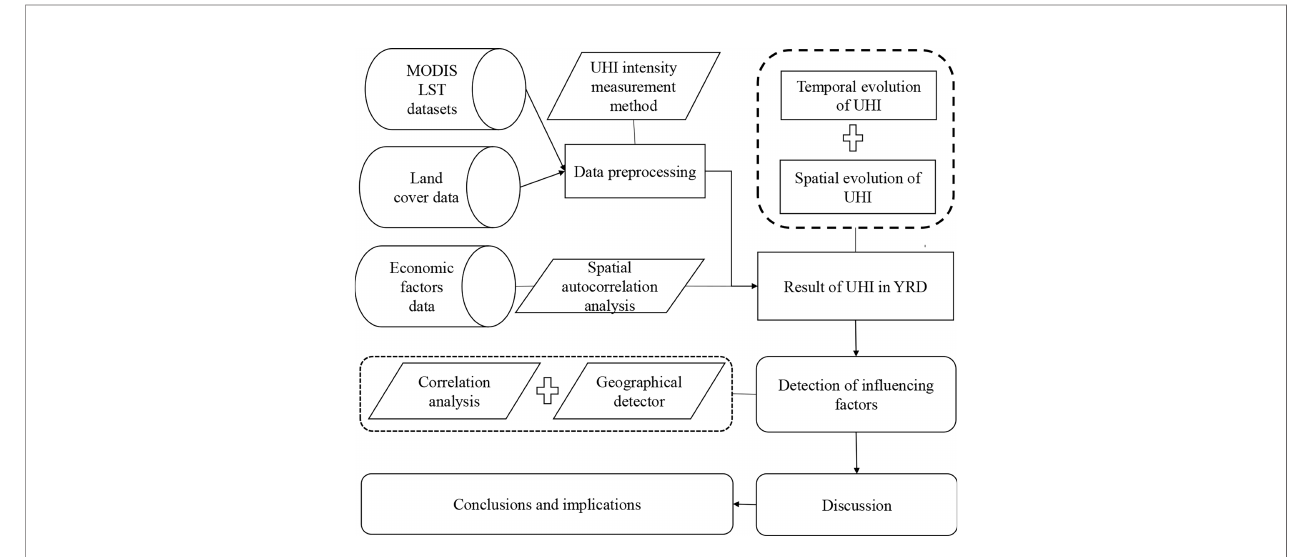
FIGURE 3 | A work fl owchart showing major processing.